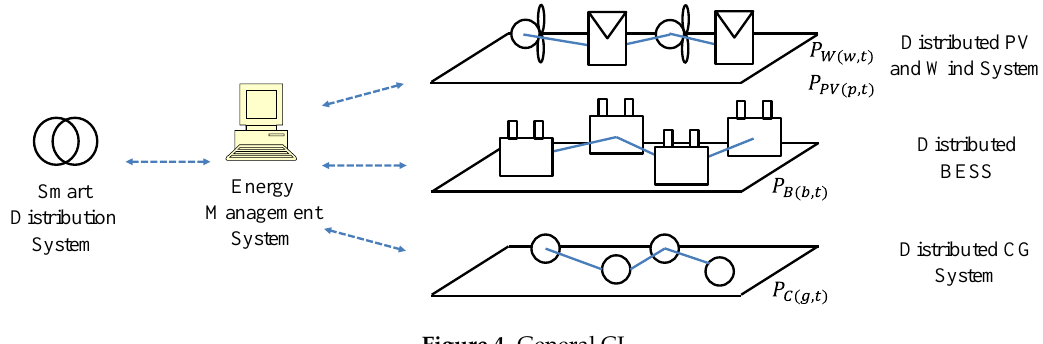
Figure 4. General CI.